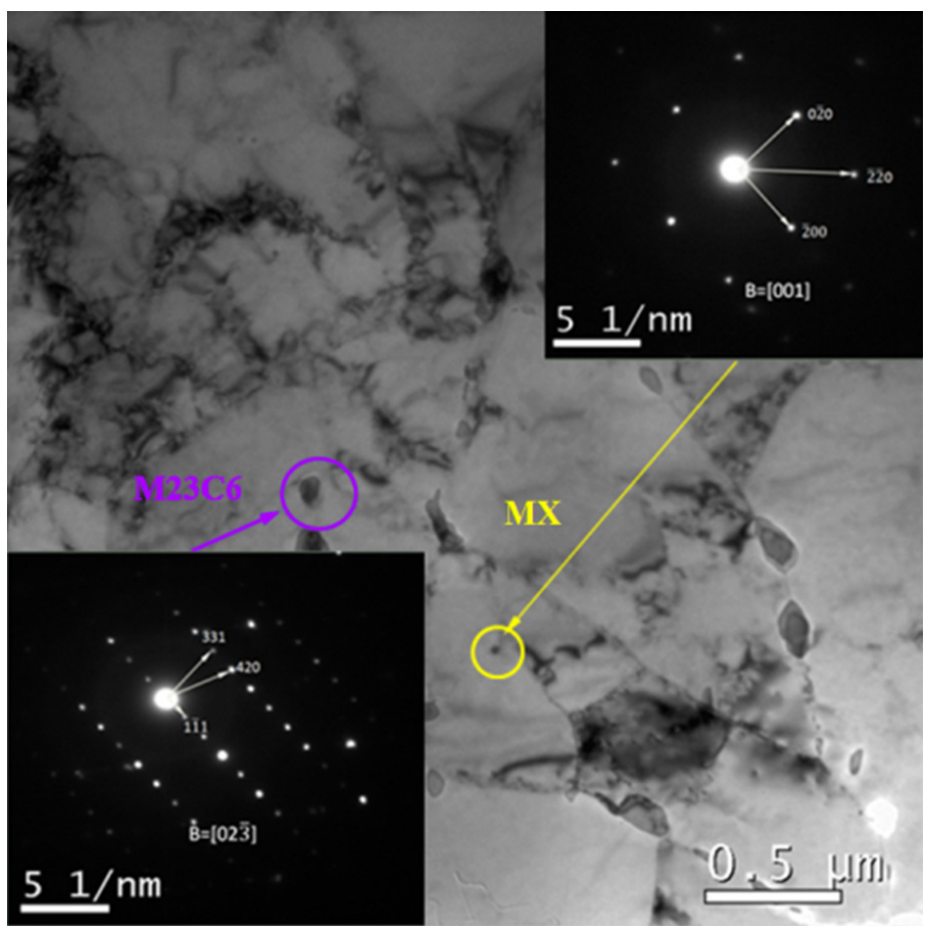
Figure 1. TEM BF image and SAED patterns of the P91 steel for initial state. Figure 2a–d are SEM images and correspond to the BSE image of the microstructure aged at 625 ◦ C for 3000 h and 5000 h. Figure 2a,b clearly illustrates the preferential nucleation sites for Laves phase are the prior austenite grain boundaries and martensite lath boundaries.